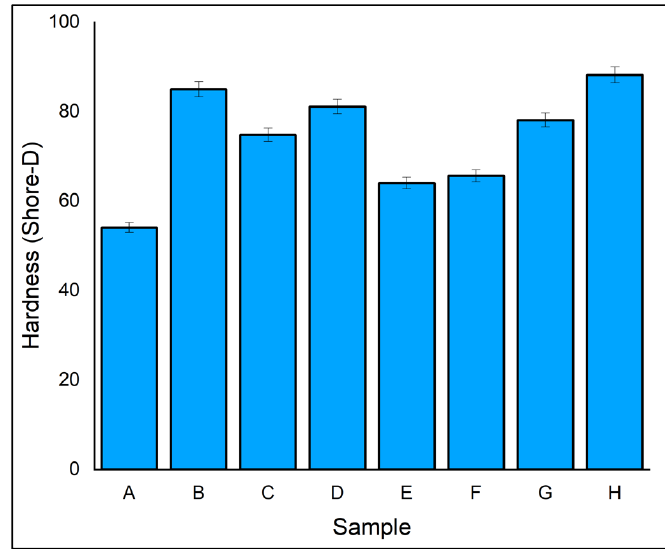
Figure 12. Hardness of specimen.